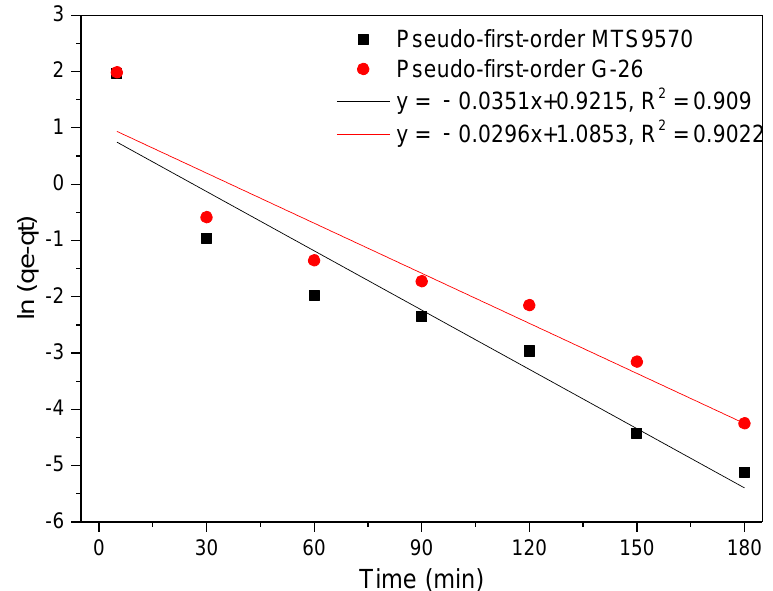
Figure 11. Pseudo-first-order modelling for adsorption of Pb(II) onto G-26 and MTS9570 resins.